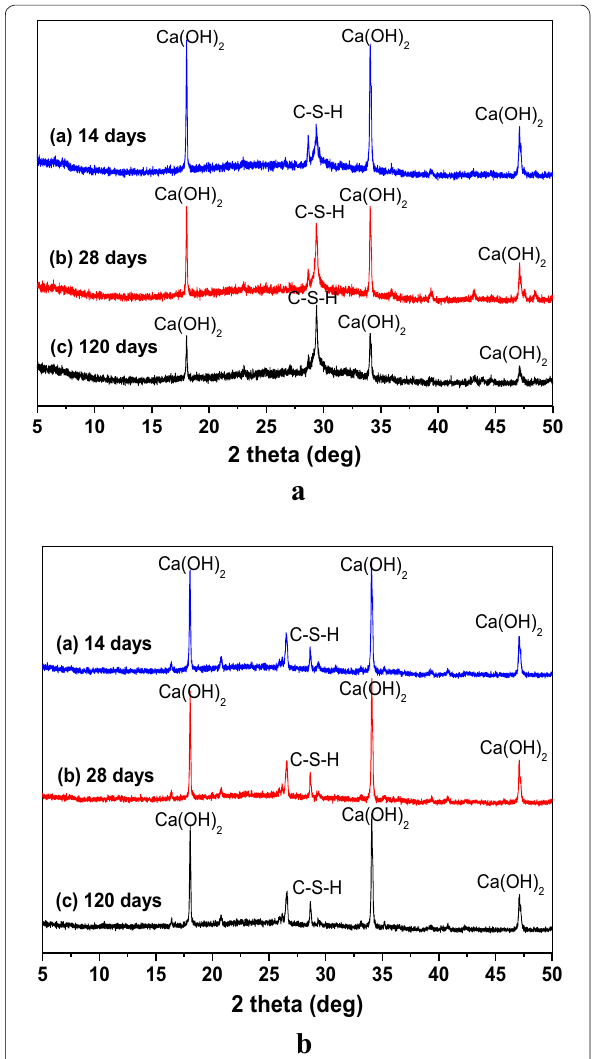
Fig. 9 X-ray fluorescence (XRF) patterns of WG-a-30 and FA30 cement mortars at different curing ages. a WG-a-30 cement mortar. b FA30 cement mortar.